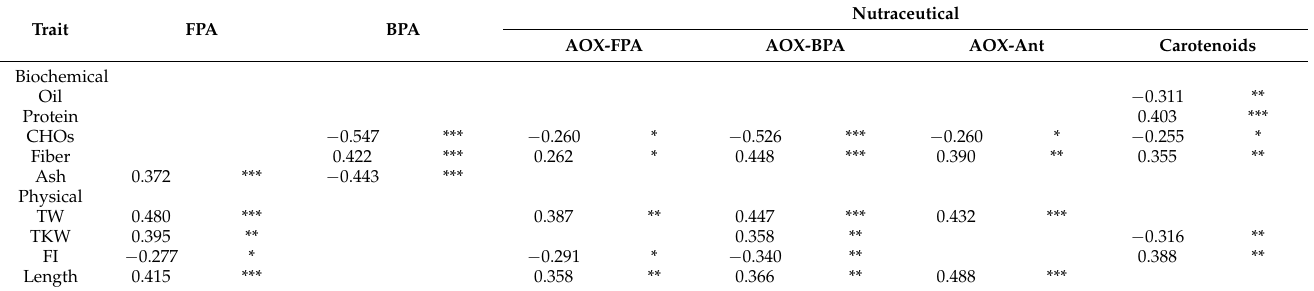
Figure 1. Mean comparative analysis of nutraceutical compounds and antioxidant activity of kernels from 30 subtropical blue maize hybrids “Vitamaiz” divided by its crosses. ( A ) Free and bound phenolic acid content. ( B ) Antioxidant activity of free and bound phenolic acids. ( C ) Anthocyanin content and antioxidant activity. ( D ) Total carotenoid content. ** Significant at p < 0.01. *** Significant at p < 0.001; Bars on each sample mean the standard error of three replicates. Table 3. Pearson correlation analysis between biochemical, biophysical, and nutraceutical properties of kernels from 30 Vitamaiz hybrids grown in two subtropical environments in